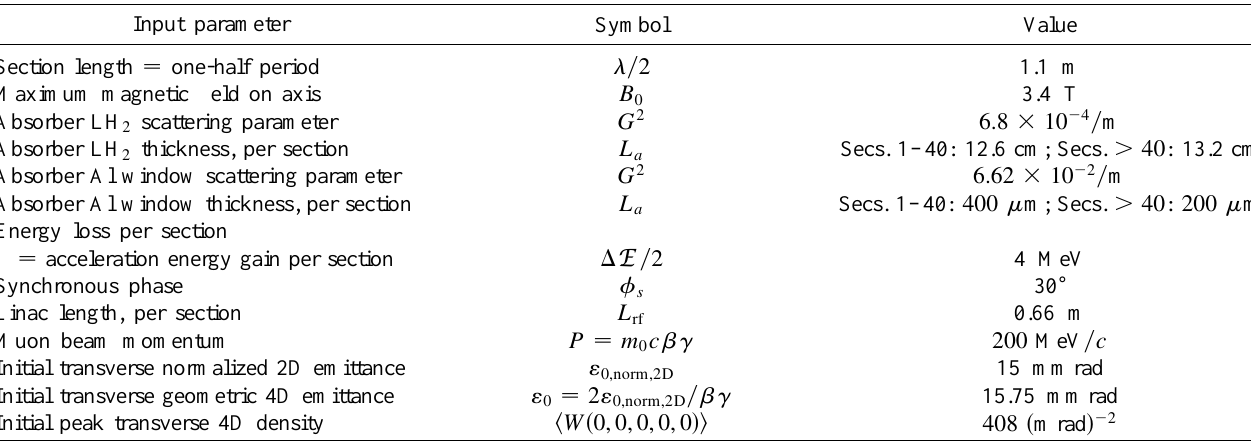
TABLE I. Cooling channel and input beam